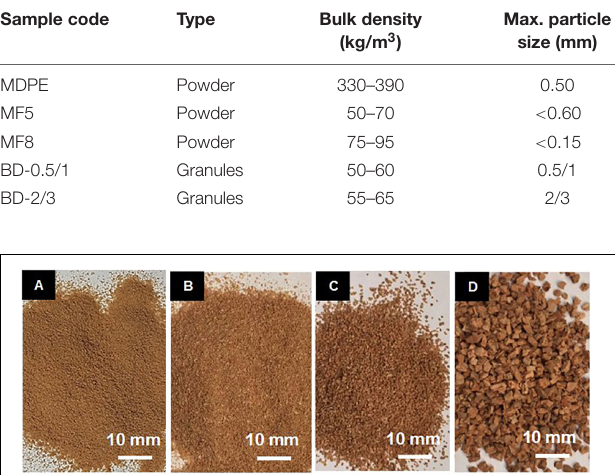
FIGURE 1 | Cork powders (A) MF8 and (B) MF5 and cork granules (C) BD-0.5/1 and (D)